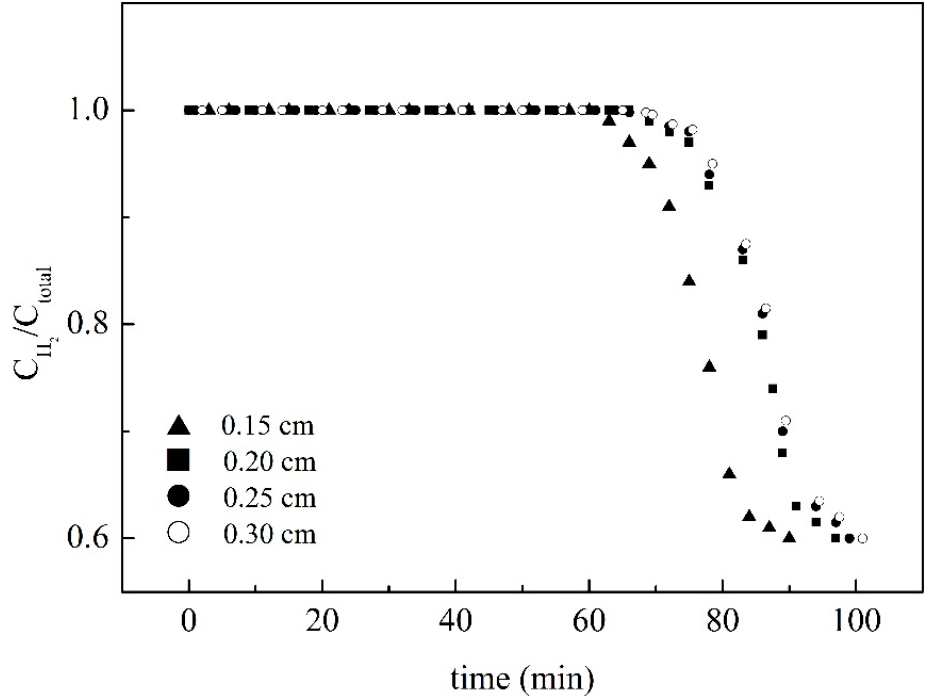
Figure 7. The effect of membrane thickness on adsorption behavior.